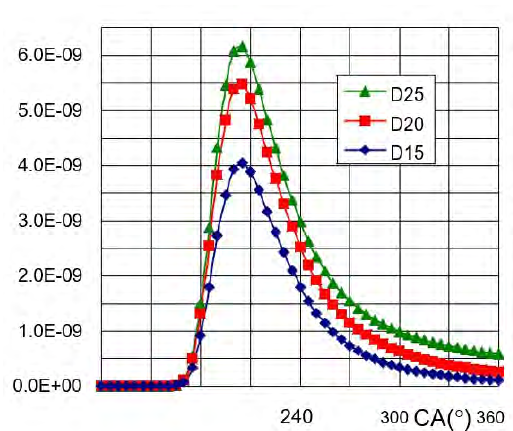
Figure 7. Soot concentration vs crank anglewith different diesel content in thefuel (n=2400rpm, ϕ =1)